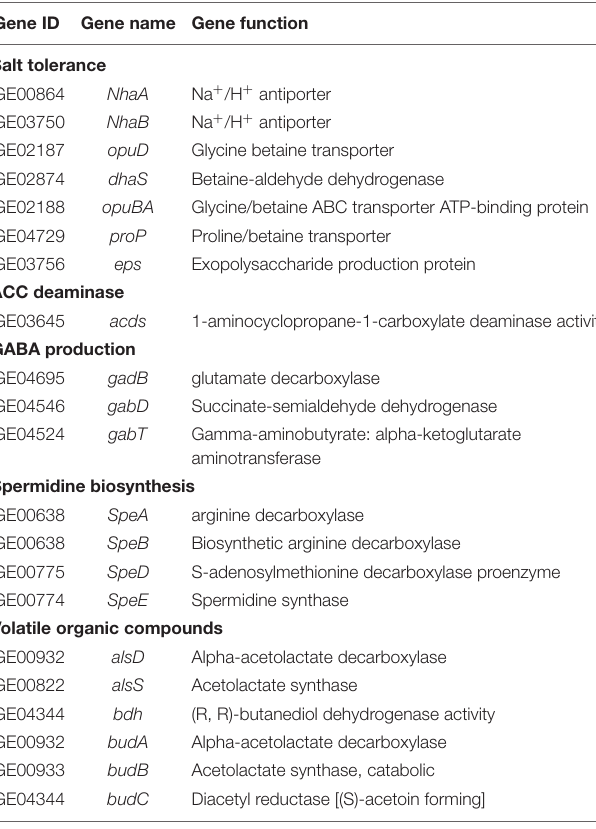
TABLE 3 | Genes related to plant stress resistance improving in the Rahnella victoriana JZ-GX1